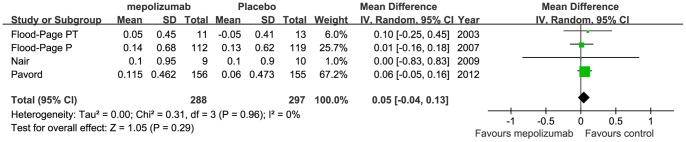
The effects of mepolizumab on FEV1 (L).